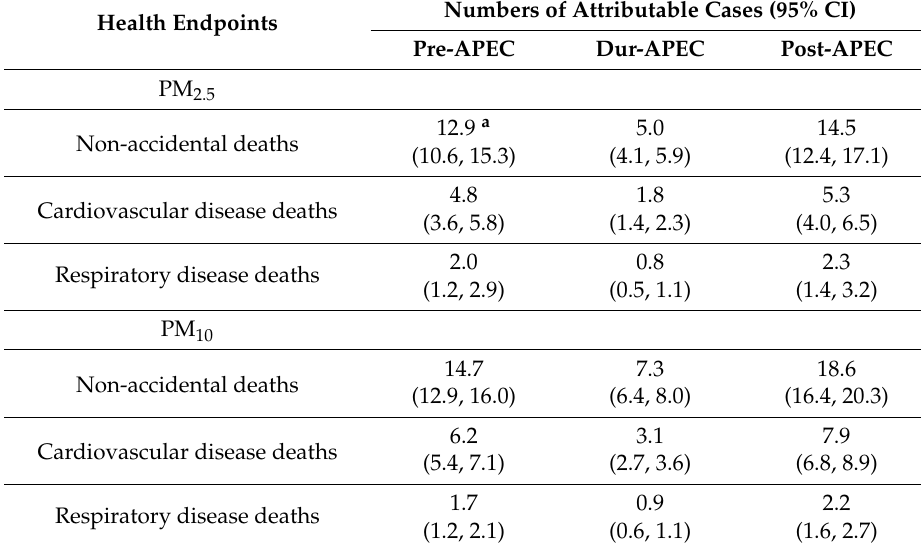
Table 3. Estimated daily numbers of deaths attributed to PM pollution pre-, during- and